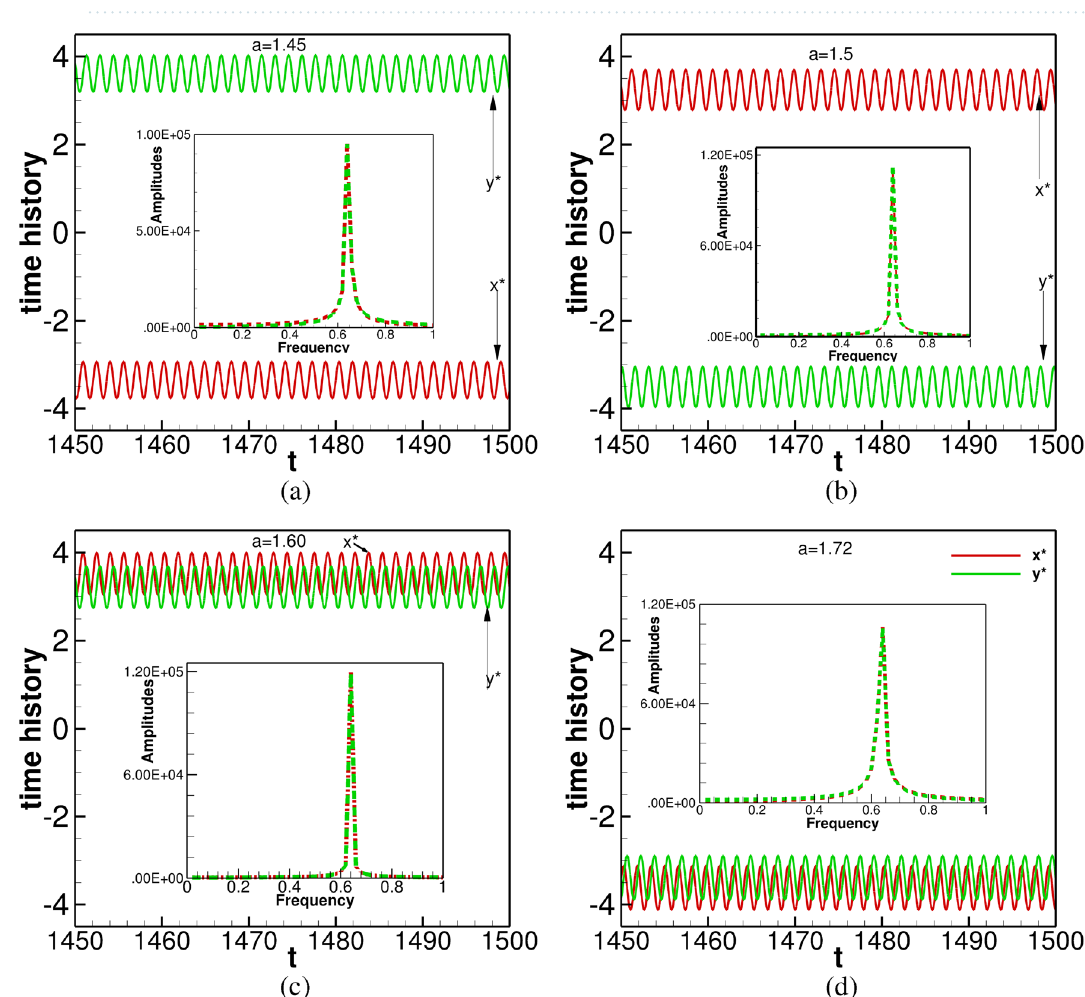
Figure 7. Time history plots of tip coordinates ( x ∗ , y ∗ ) , and their corresponding power spectra in small frames (inset), with obstacle for a : ( a ) 1.45, ( b ) 1.50, ( c ) 1.60 and ( d )